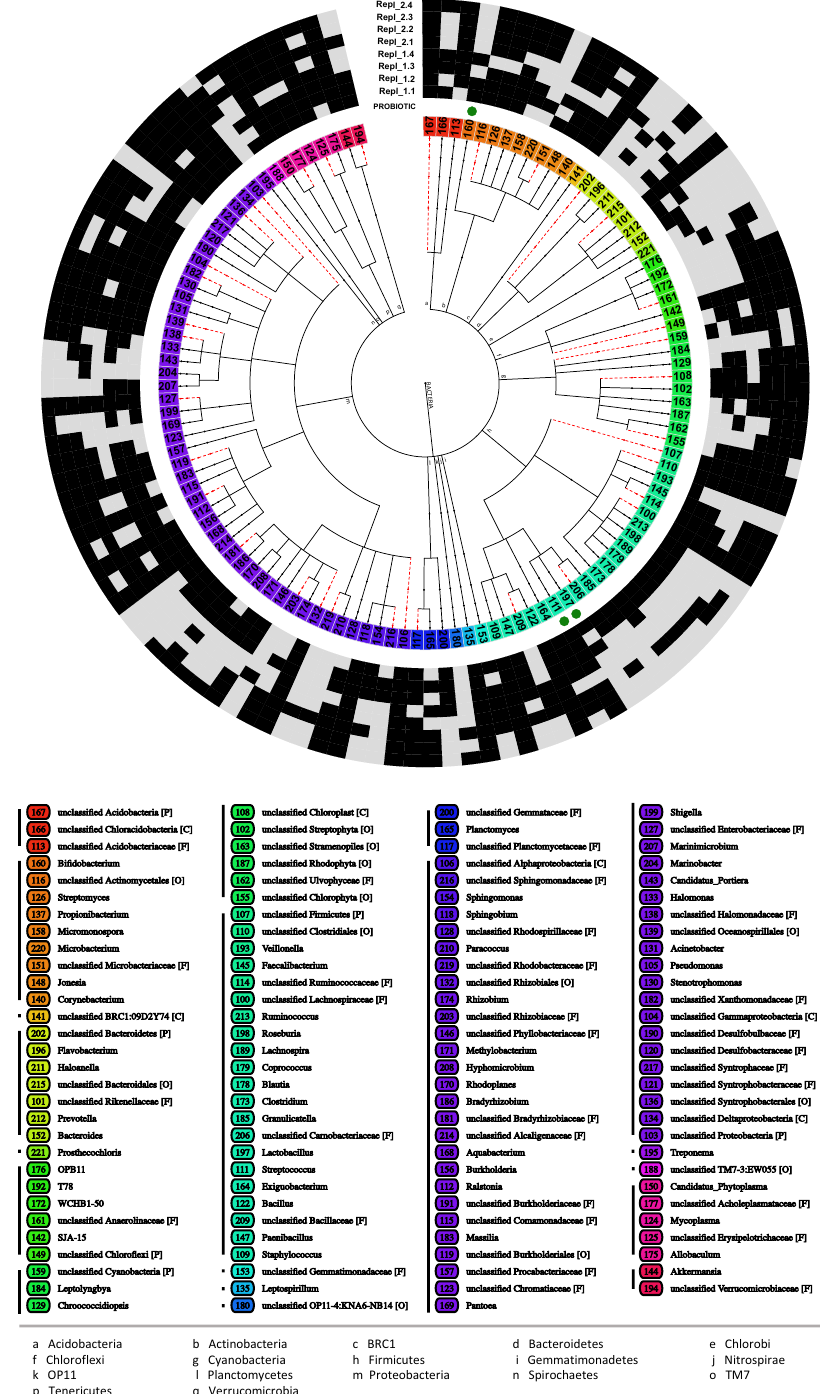
Figure 4. Taxonomic a ffi liation and absence-presence pattern of Lepidium sativum phyllosphere microbiota bacterial genera detected by the PhyloChip G3 technology. Taxonomic assignment of the genus-specific OTUs are displayed on the leaves and colored according their phyla (a–q). Spotted red lines indicate uncertain assignments, whereby their last known taxonomic rank (P: Phyla; C: Class; O: Order; F: Family) is listed behind the respective a ffi liation in the legend. The surrounding circles, describing the four replicates for individual experiments (Repl_1, Repl_2), reveal the presence (black) and absence (gray) of the appropriate genus. Genera with high probability of containing probiotic species are marked with a green